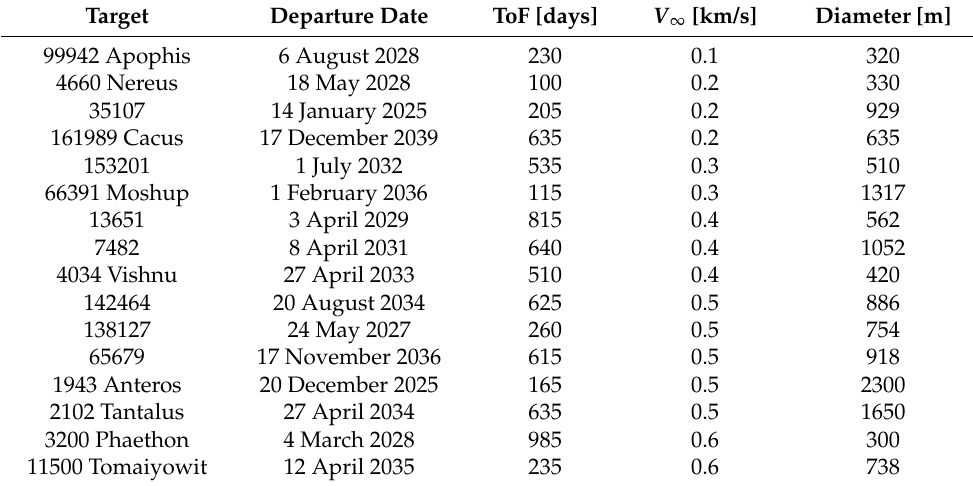
Table 3. Target NEAs